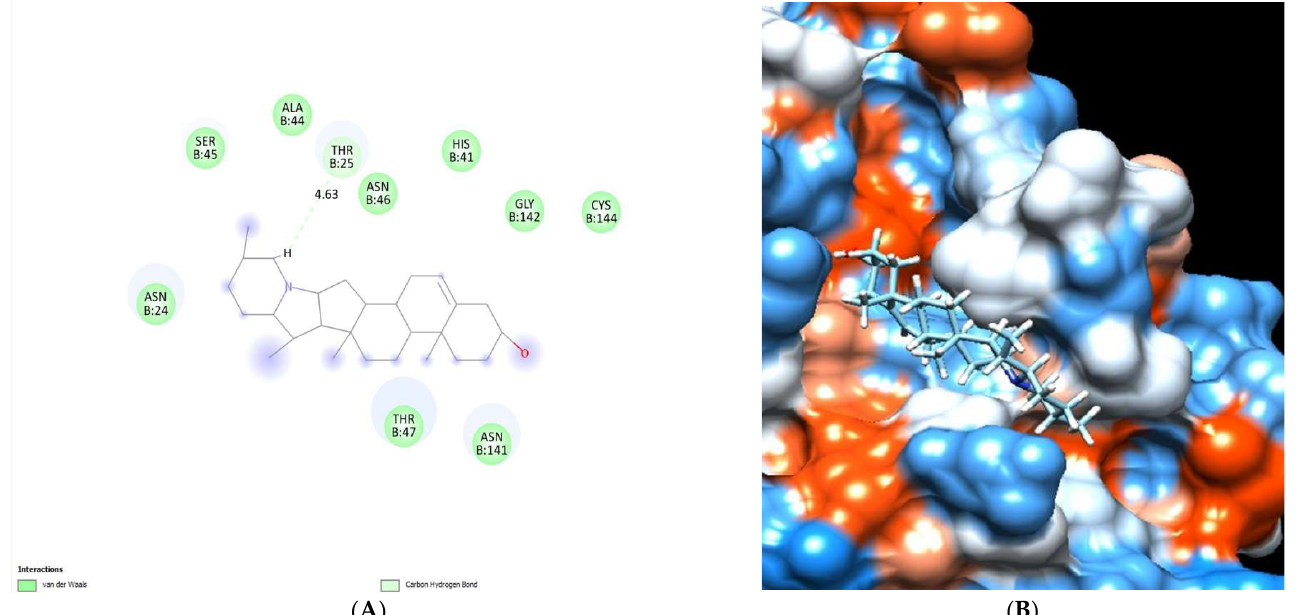
Figure 18. Solanidine docked in HCo-V 229E main protease. Hydrogen bonds are represented in green, and the pi interactions are represented in green lines ( A ), with a mapping surface showing solanidine occupying the active pocket of HCo-V 229E main protease ( B ).